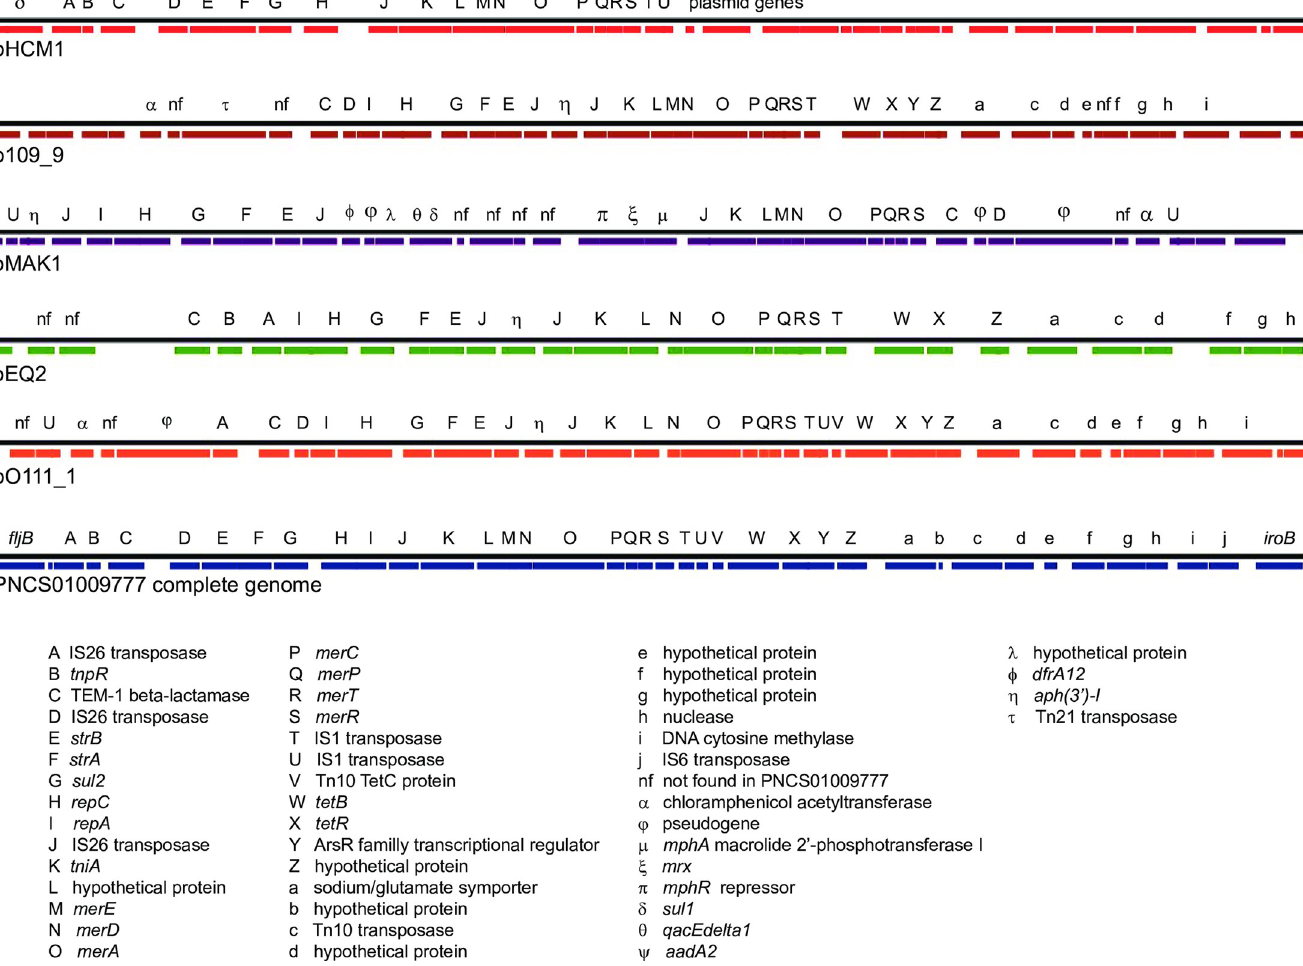
PLOS ONE | https://doi.org/10.1371/journal.pone.0236436 July 27,